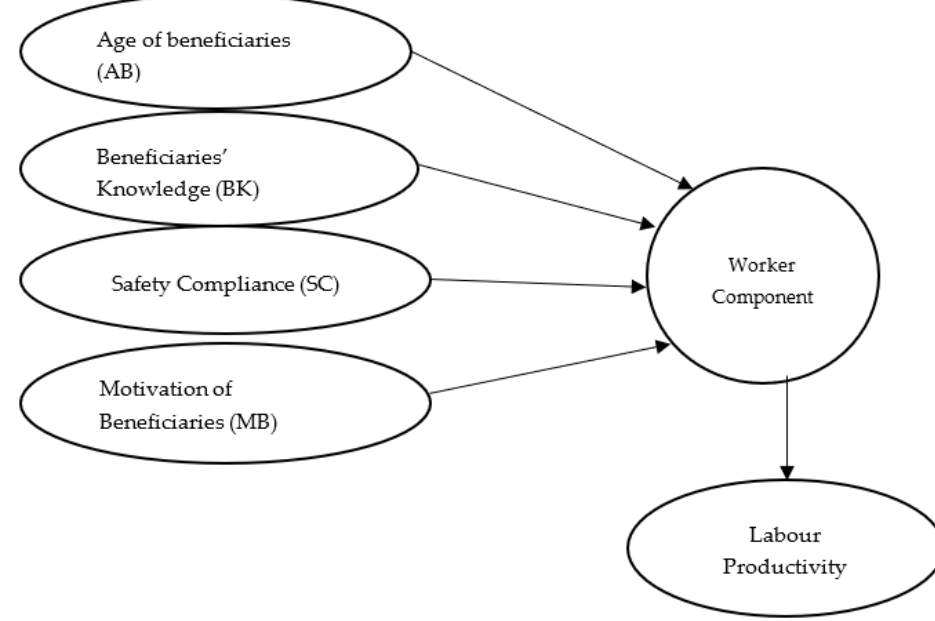
Figure 2. Framework for productivity of construction workers on labour-intensive works .